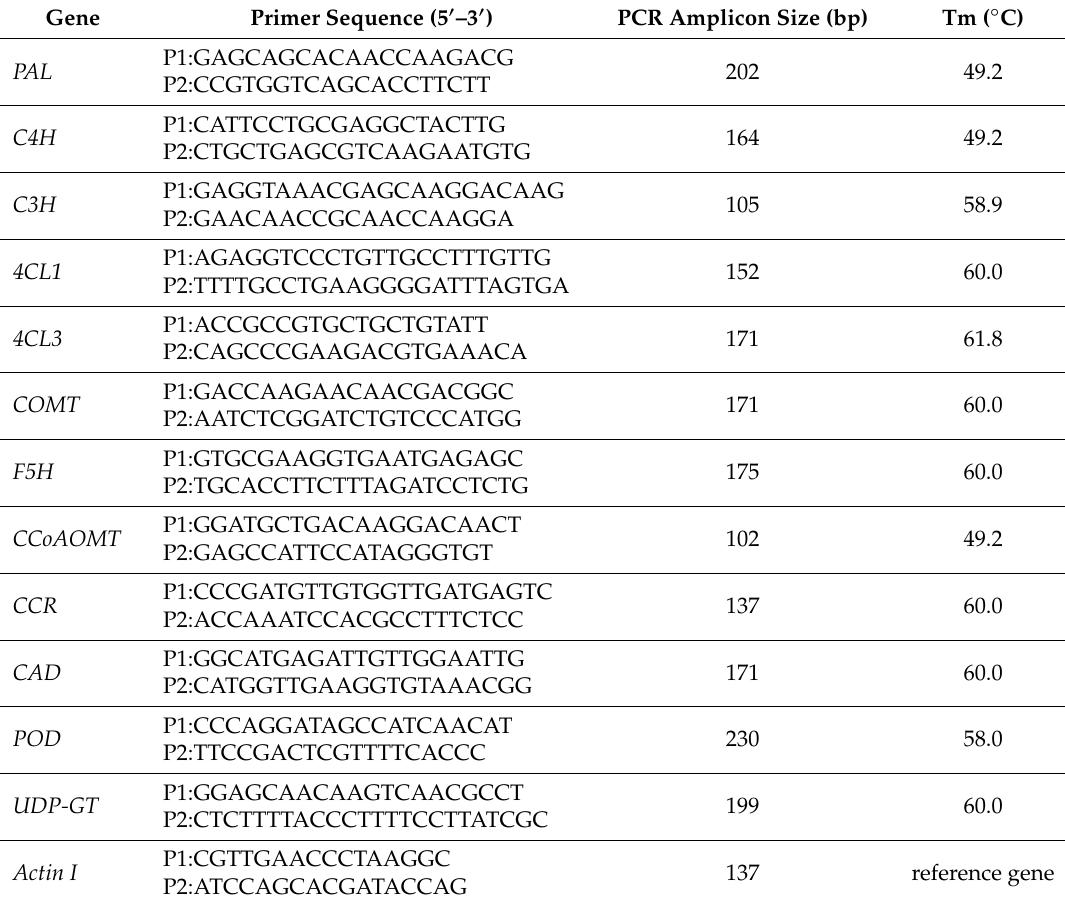
Table 1. Primers used in the experiment and its amplification